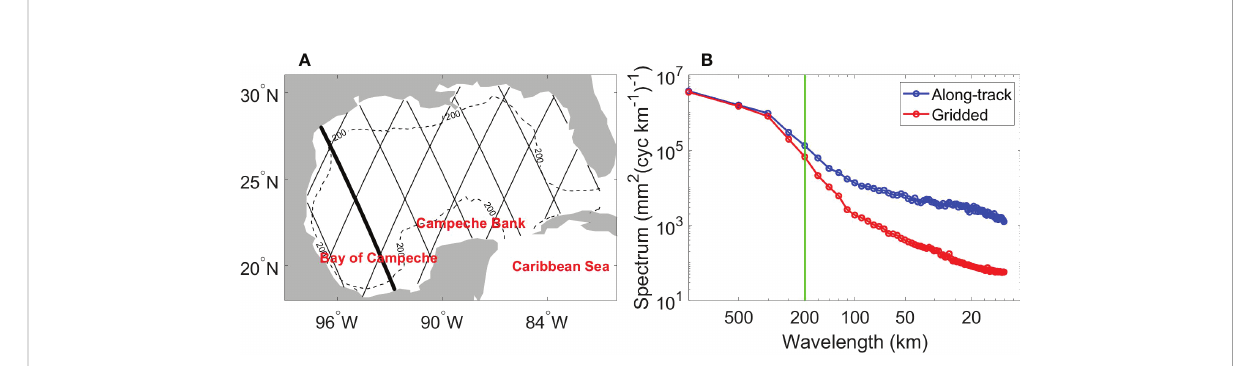
FIGURE 1 (A) Ground tracks of the TOPEX/Poseidon satellite in the GoM. The thick black line represents the track along which the wavenumber spectrum of ADT was estimated. The dashed black line represents the 200-m isobath. (B) Wavenumber spectrum of along-track and gridded ADT along the track marked by the thick black line in (A) . The vertical green line marks the wavelength of 200